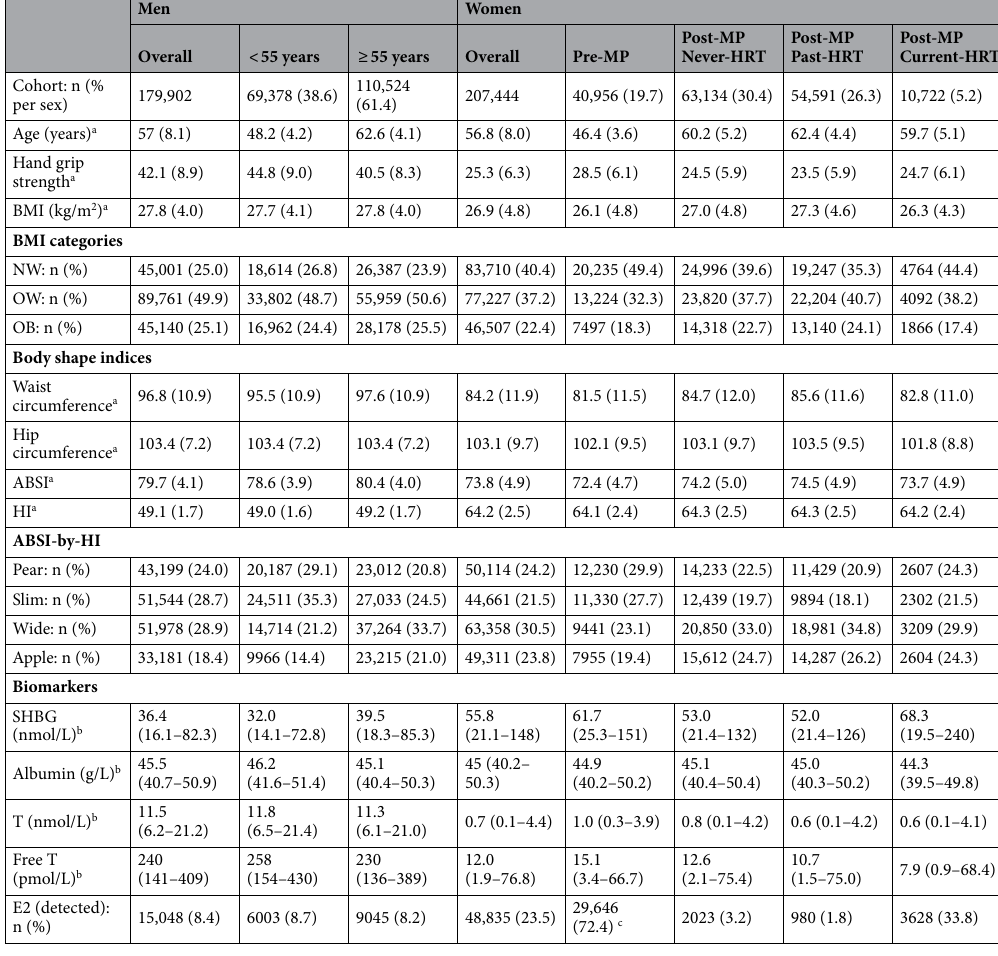
Table 1. Anthropometric characteristics of study participants and biomarker levels. ABSI a body shape index (cut-offs ≥ 80 for men, ≥ 73 for women), Apple large-ABSI-small-HI, BMI body mass index, E2 oestradiol, HI hip index (cut-offs ≥ 49 for men, ≥ 64 for women), HRT hormone replacement therapy, NW normal weight (BMI ≥ 18.5 to < 25 kg/m 2 ), OB obese (BMI ≥ 30 to < 45 kg/m 2 ), OW overweight (BMI ≥ 25 to < 30 kg/m 2 ), Pear small-ABSI-large-HI, Post-MP post-menopausal, Pre-MP pre-menopausal, SHBG sex hormone binding globulin, Slim small-ABSI-small-HI, T testosterone, Wide large-ABSI-large-HI, n ( % ) number (percentage from total per column); a mean (standard deviation); b geometric mean (95% reference range); c for Pre-MP women, E2 (pmol/L) was 318 (50–2007) and free E2 (pmol/L) was 6.5 (1.1–39.6). Participant groups are defined in Supplementary Fig.